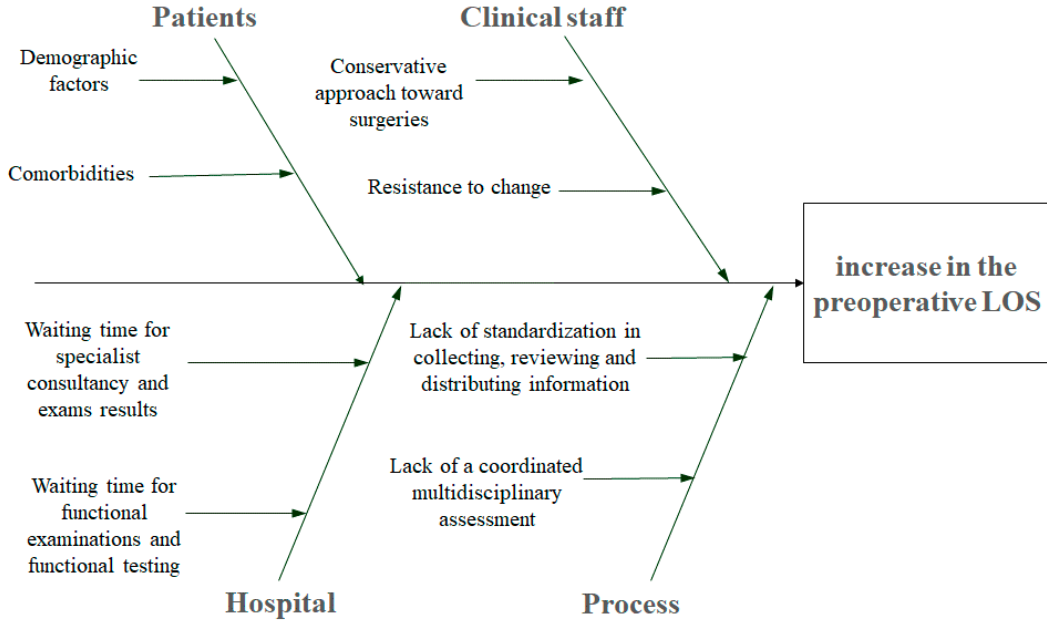
Figure 2. Ishikawa fishbone diagram.